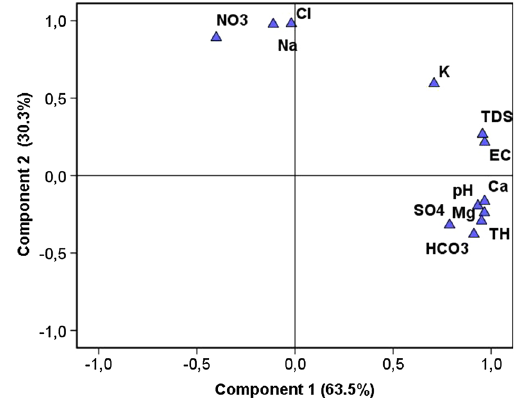
Fig. 4 R-mode factor scores for factors 1 and 2 of the groundwa- ter samples. Potassium is projected half way between geogenic and anthropogenic factors